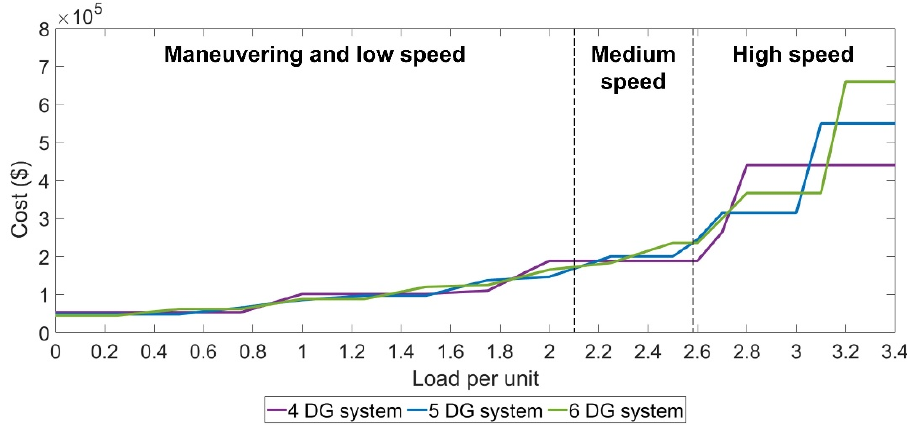
25 of 34 Figure 18. Annual maintenance service costs breakdown at a 3 pu load.